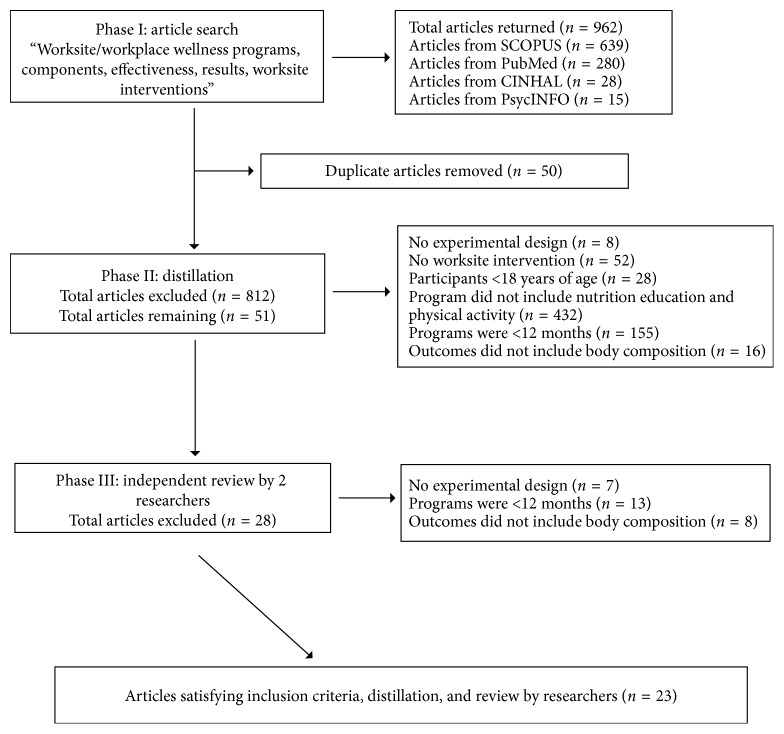
Article extraction.